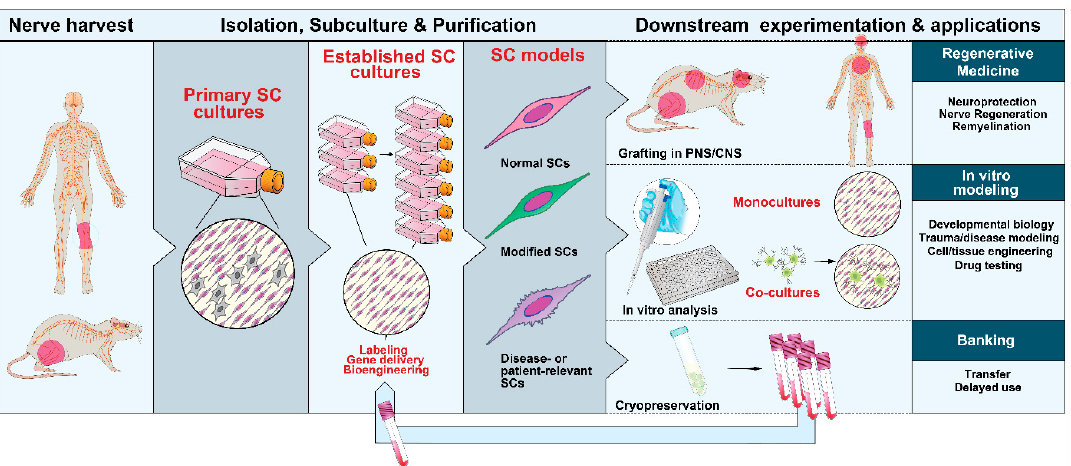
Figure 3. Nerve-derived SC cultures: sources, expandability and applications. SCs can be isolated from neural (PNS) tissues from adult and developing animals and humans. SC cultures can be expanded with the aid of soluble factors and used in a variety of downstream applications, as indicated. Primary or expanded SCs are suitable for diverse manipulations. They can be induced to acquire mature characteristics both in vitro (with and without neurons) and in vivo after transplantation in the PNS or CNS.